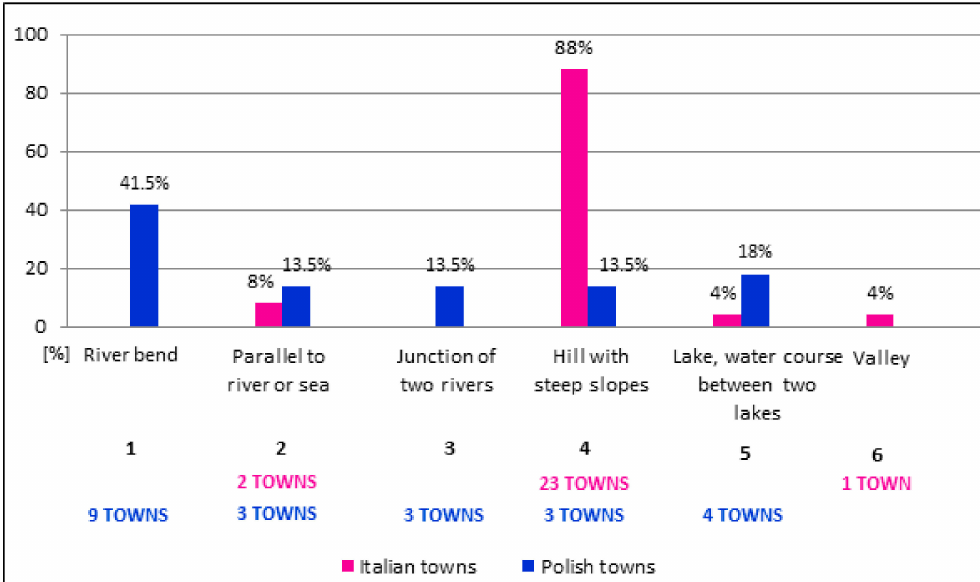
Figure 5. Topographic features in Polish and Italian towns. Source: own elaboration based on cartographic analyses.